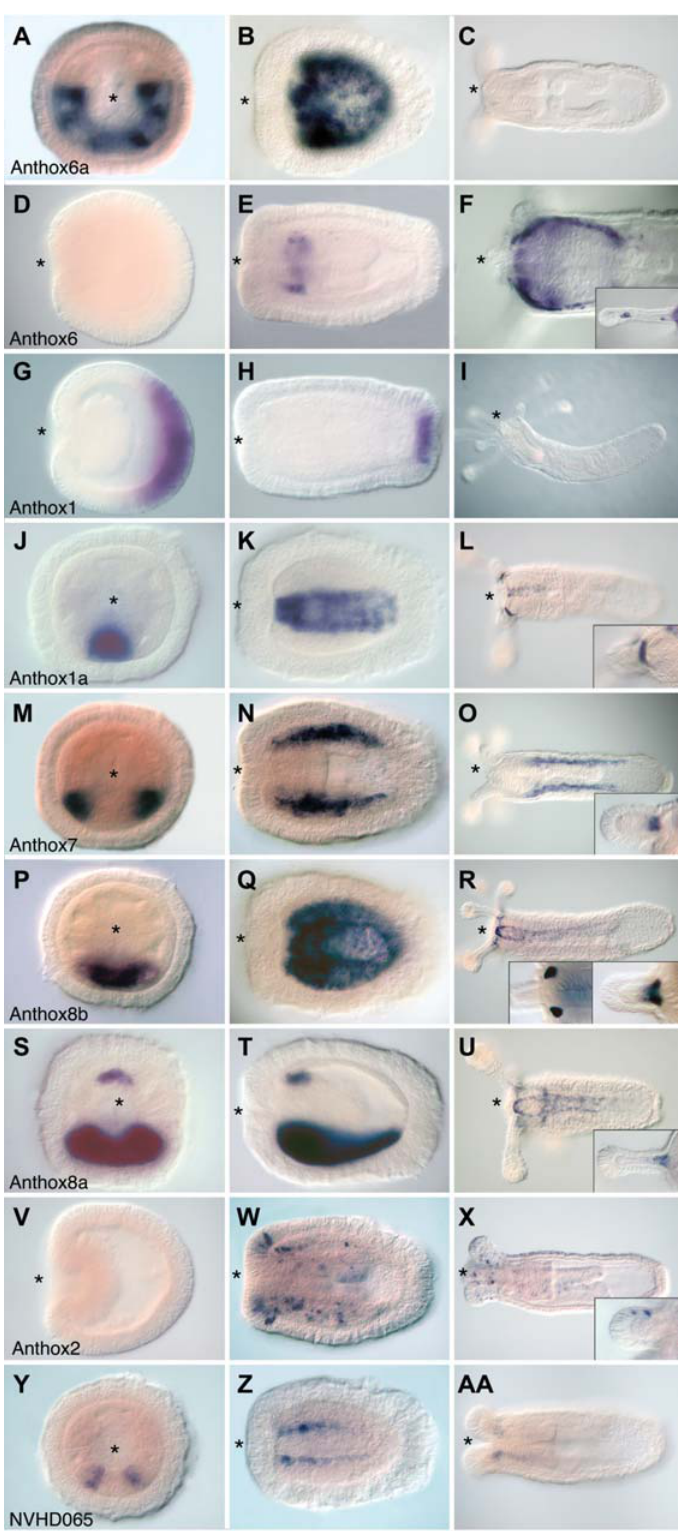
Figure 5. Developmental Expression of Hox and ParaHox homologs in Nematostella . Gene expression was assayed throughout embryonic and larval development using in situ hybridization. All images are optical sections that permit visualization of the endodermal tissue layer. Panels A, J, M, P, S, and Y are transverse sections, but all other images are longitudinal sections with the future oral end of the animal facing left. The blastopore, which becomes the mouth, is indicated by an asterisk. Abbreviations are as follows: apical tuft (at); coelenterone (coe); bodywall ectoderm (ecbw); pharyngeal ectoderm (ecph); bodywall endoderm (enbw); pharyngeal endoderm (enph); mesentery (mes); pharynx (pha); tentacle (tn).